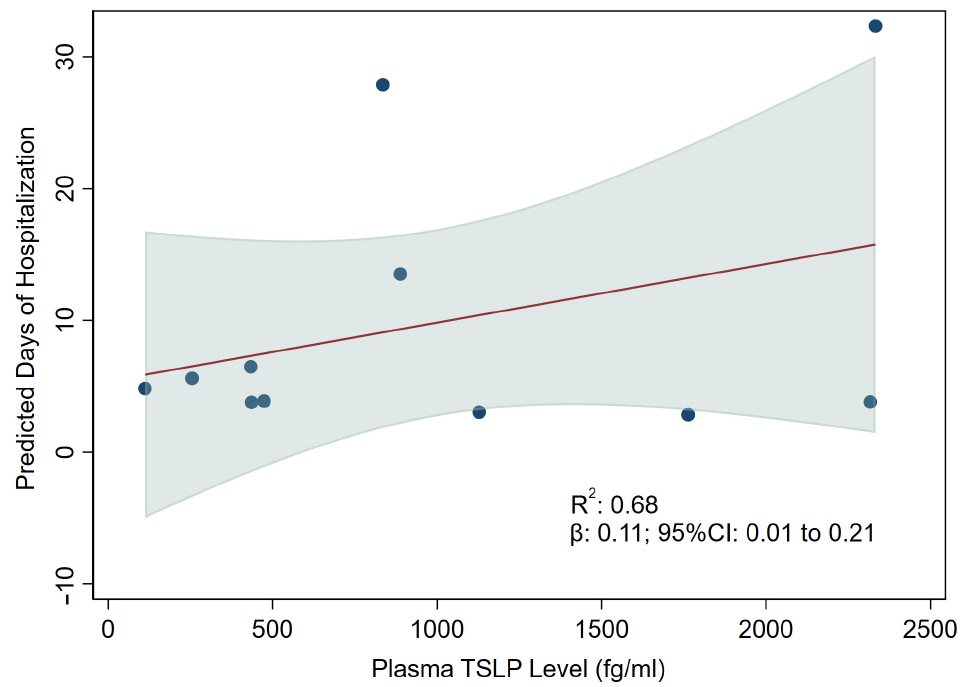
Figure 3. Association between plasma TSLP levels and days of hospitalization in COVID-19 patients. Data presented as regression coefficient ( β ) (red line) and 95% confidence interval (CI) (shaded area). Multivariable analysis was adjusted for age, sex, heart rate, respiratory rate, body temperature and SpO 2 on admission, number of comorbidities, and the interval between the date of the COVID-19-positive test result and the date of hospitalization.